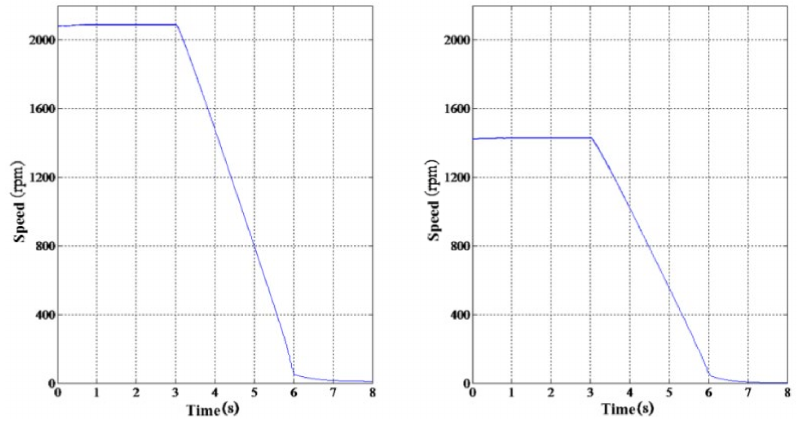
Figure 14. The speed of the SRM during the braking process.